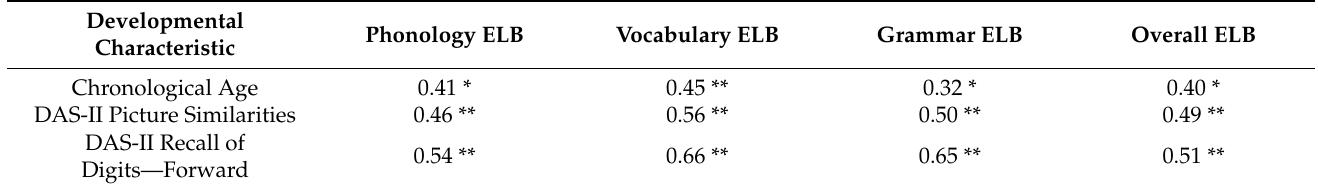
Table 5. Spearman correlation coefficients between Expressive Language Benchmarks and Broader Developmental